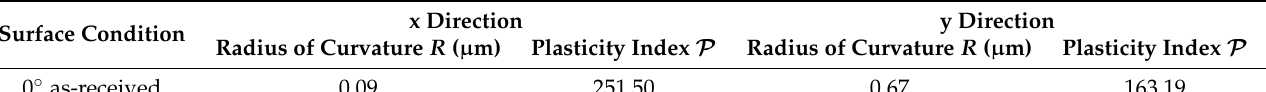
Table 2. Average radii of curvature R of roughness texture features and corresponding plasticity indices of various surface P